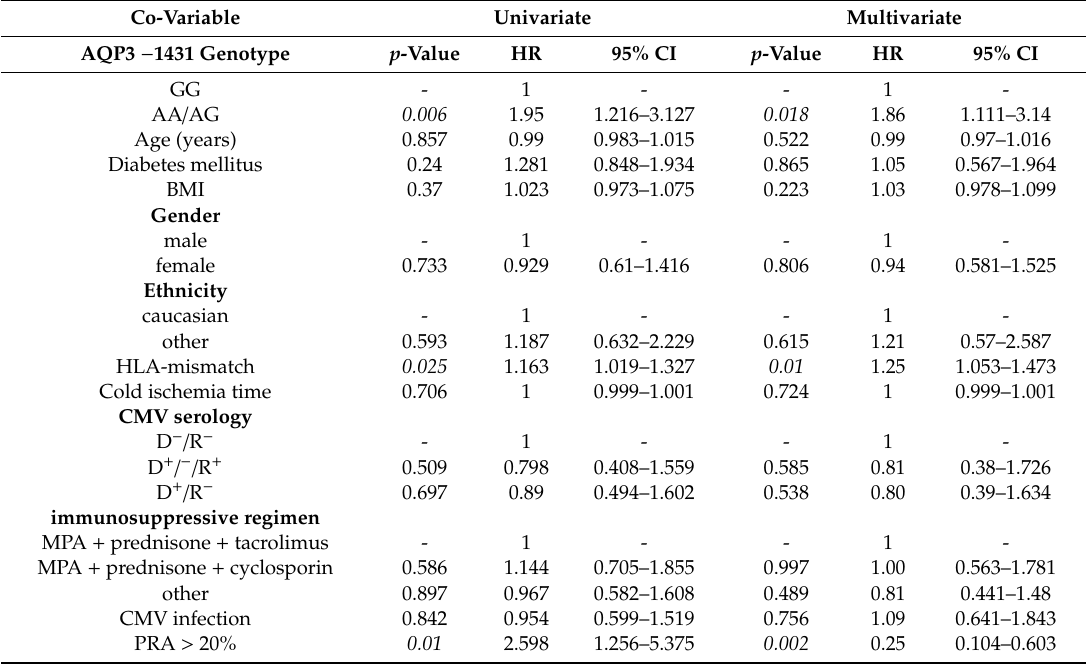
Table 3. Multivariate Cox-regression of graft rejection over 360 days after